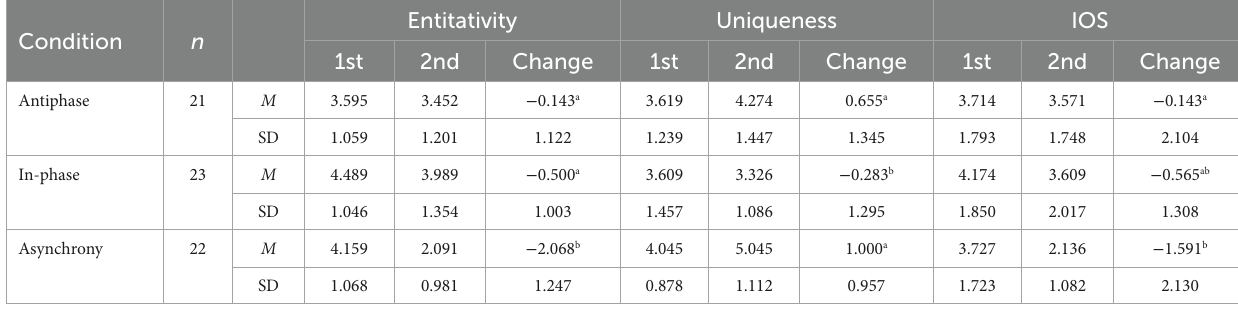
TABLE 2 Impact of phase synchrony on perceived entitativity, uniqueness, and IOS (self-other overlap).